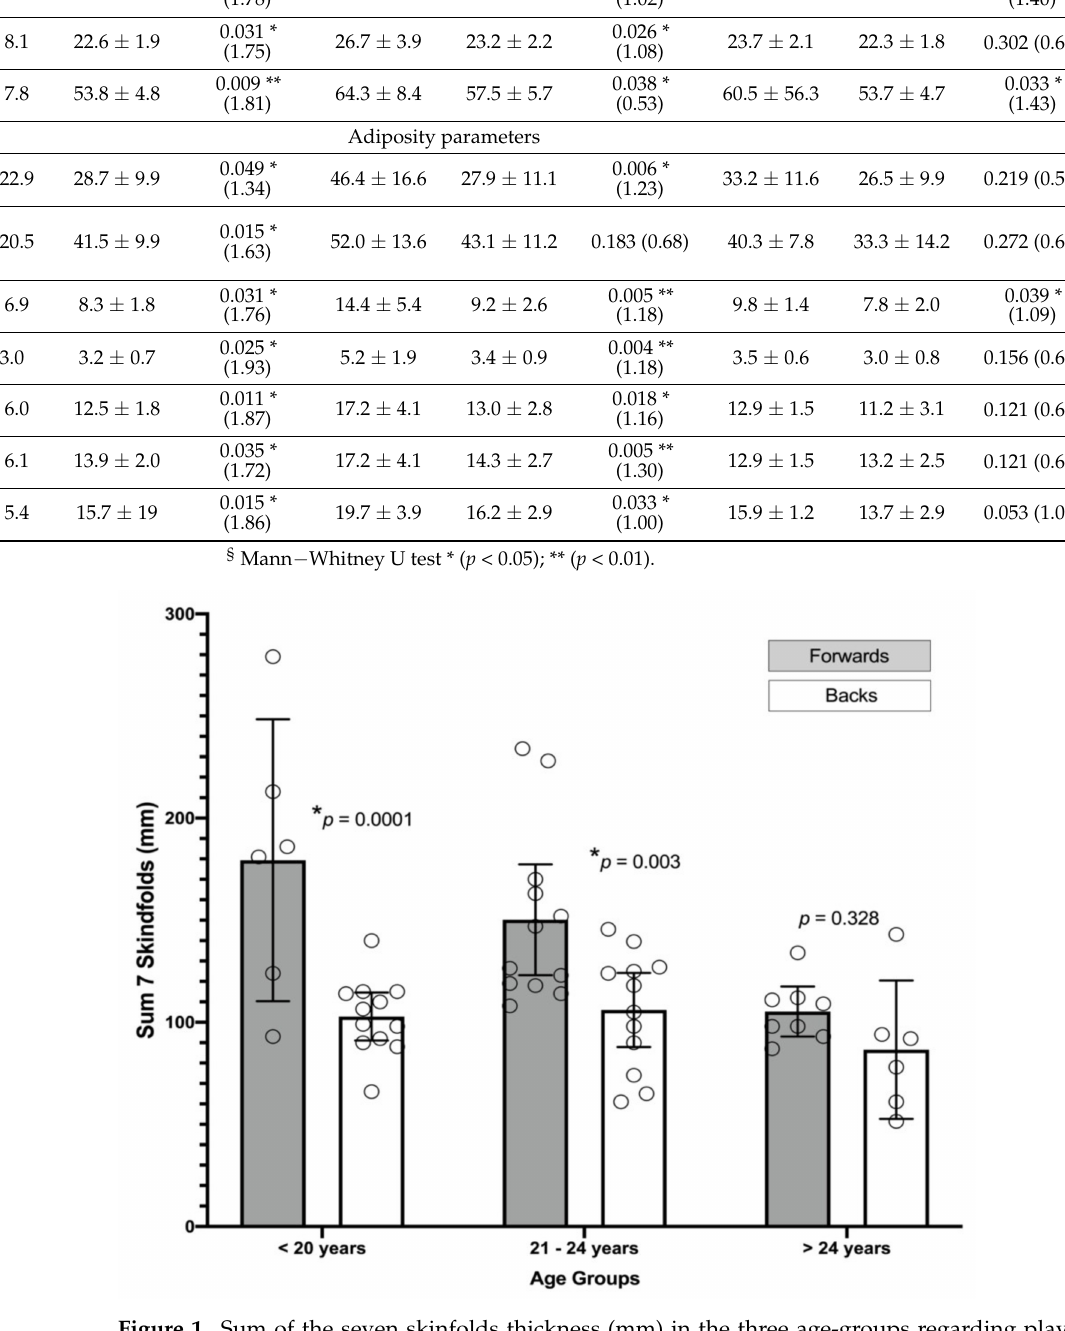
Figure 1. Sum of the seven skinfolds thickness (mm) in the three age-groups regarding players position (i.e., forwards and backs) and age (i.e., <21 years, 21–25 years, and >25 years). Bars represent the mean and 95% of confident interval. * Asterisk represent significant differences ( p <